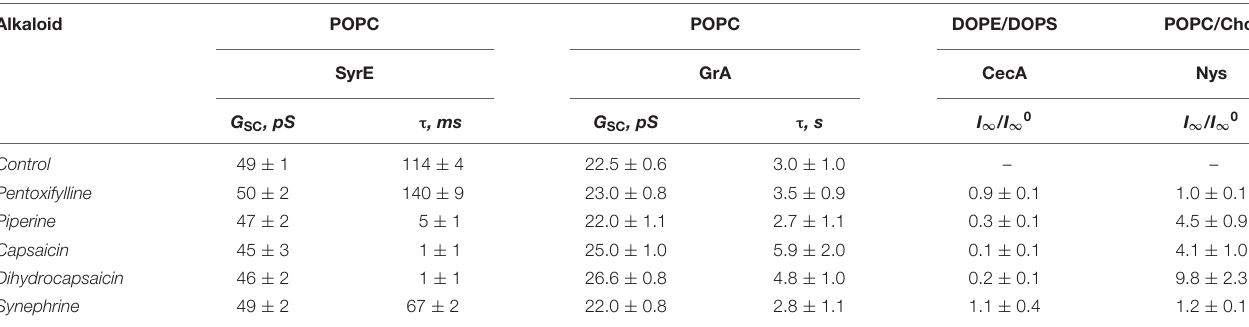
TABLE 2 | Regulation of ion channel functioning by different alkaloids: G SC – the conductance of single SyrE- or GrA-channels in the absence and presence of 0.4 mM alkaloid at V = 200 mV; τ – the dwell time of SyrE or GrA channels; I ∞ /I ∞ 0 – the ratio of the transmembrane current induced by the CecA or Nys in the presence and in the absence of alkaloids at V = 50